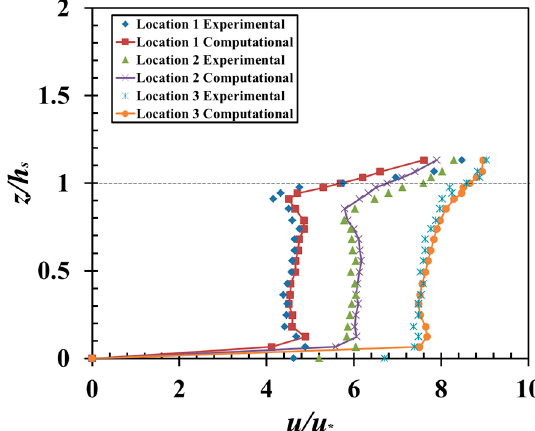
Figure 2. Comparison of simulated velocity profiles with the experimental data of Liu et al. [27]. The dotted line shows the top of submerged vegetation.